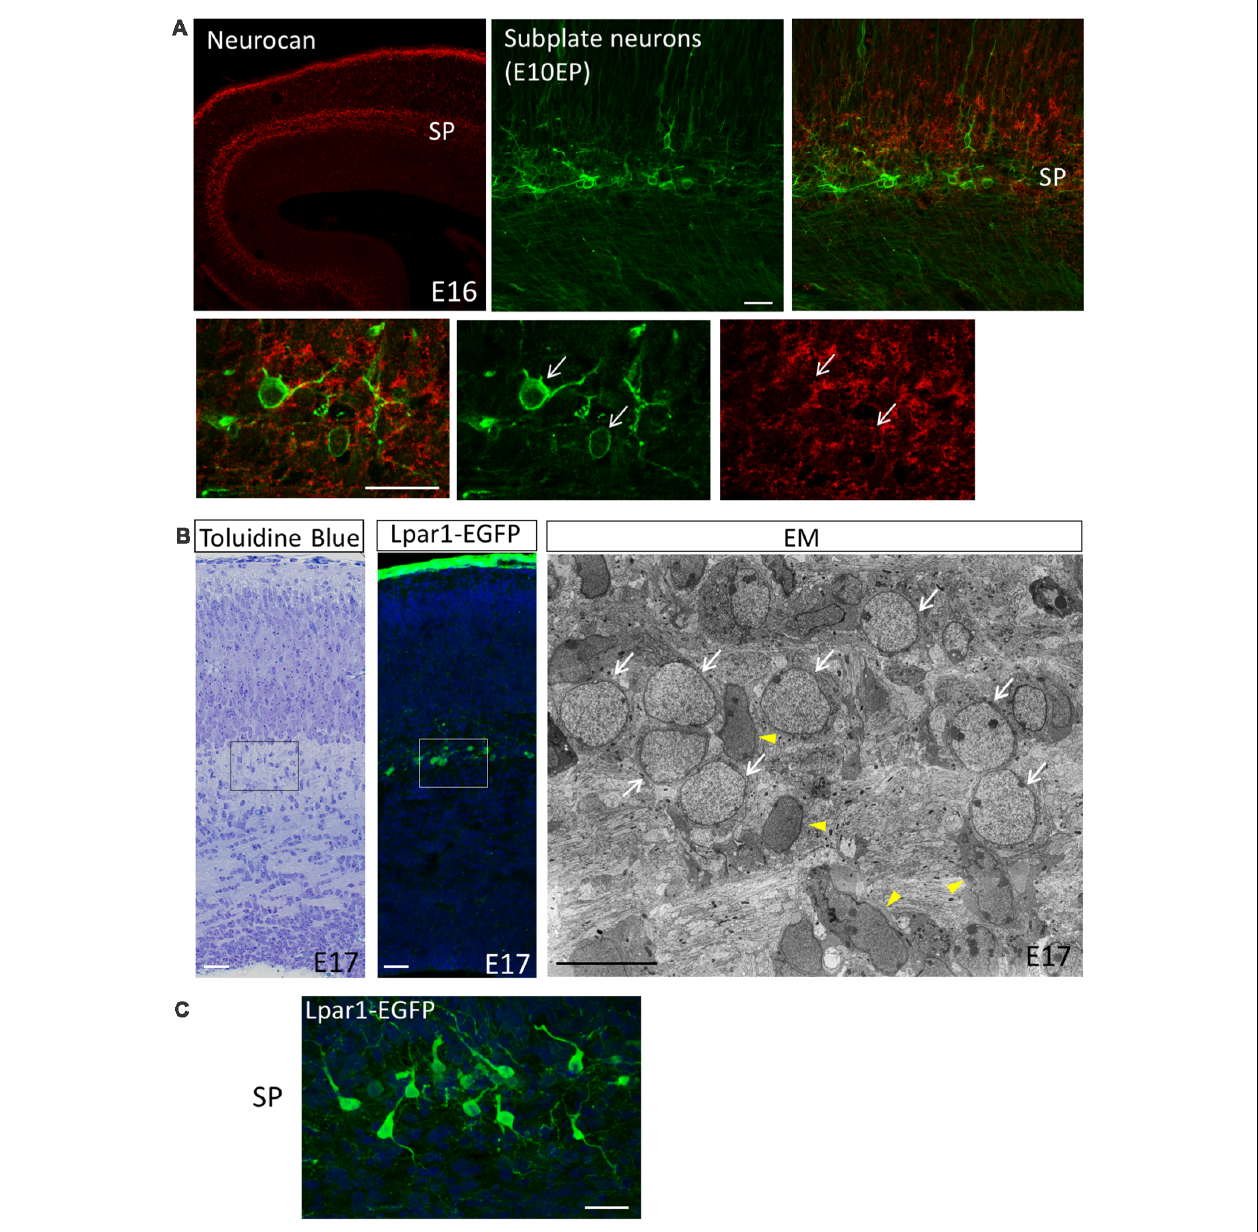
FIGURE 1 | The subplate layer is rich in extracellular matrice (ECM). (A) Immunostaining revealed that the SP layer is rich in Neurocan (Neuronal CSPG). Subplate neurons (SpNs) were labeled with GFP (arrows) by in utero electroporation at E10.5 and fixed at E16. (B) Toluidine Blue staining, Lpar1-EGFP mouse and electron microscopic observation of the sections at E17 clearly indicate morphology of SpNs. White arrows indicate SpNs and yellow arrowheads indicate migrating neurons. (C) Higher magnification of SpNs of the Lpar1-EGFP mouse cortex at the E17 stage. Scale bars, 10 µ m for EM image in (B) , 20 µ m for the rest of